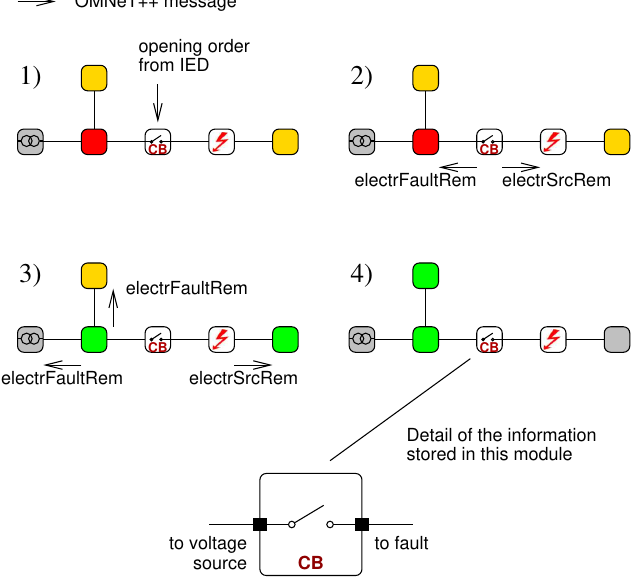
Figure 4. Steps (1)–(4) during the opening of a circuit